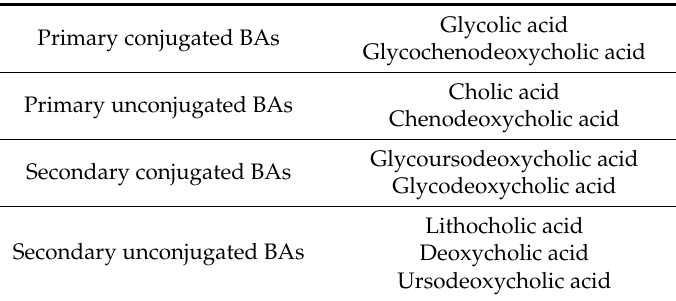
Chemical structure of deoxycholic acid (DCA). The molecular weight of DCA is 392.572 g/mol. Table 1. Classification of bile acids (BAs) used in this